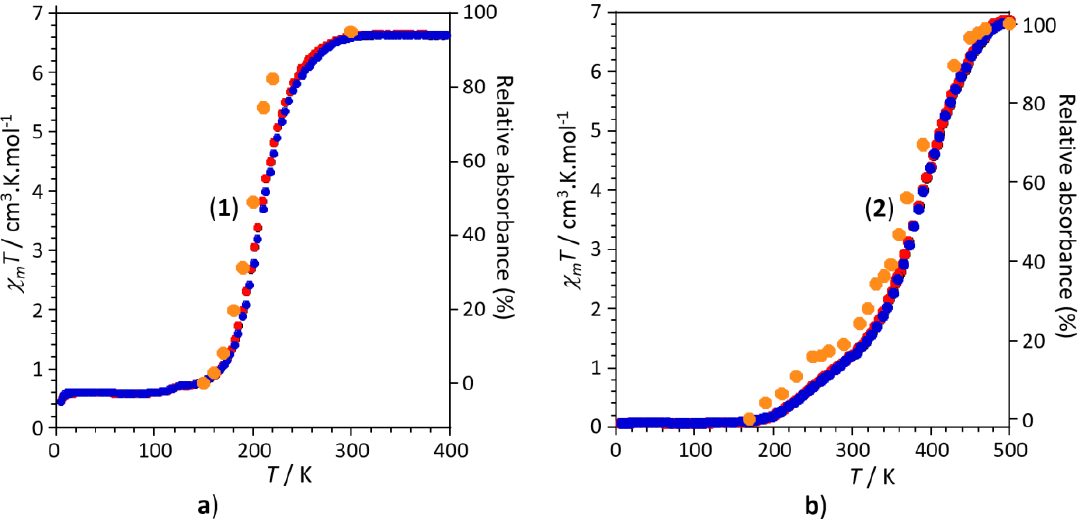
Figure 5. ( a ) Temperature dependences of the χ m T product and of the relative absorbance of the ν (CN) band observed at 2063 cm − 1 ( • ) for compound 1 . ( b ) Temperature dependences of the χ m T product and of the relative absorbance of the ν (CN) band observed at 2183 cm − 1 ( • ) for compound 2 .